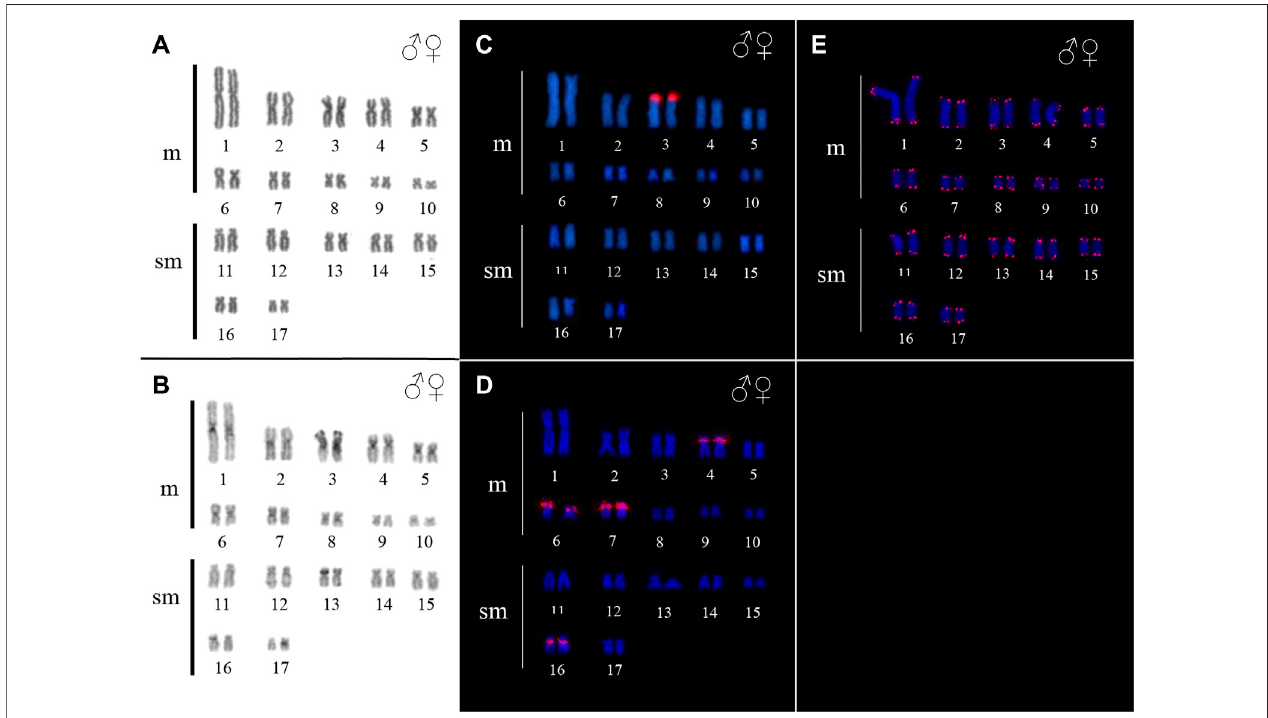
FIGURE 3 | Karyotype of Ancistrus sp. 2. In (A,B) karyotype stained with Giemsa and C-banding, respectively; in (C – E) in situ location of 18S rDNA, 5S rDNA and telomeric sequences, respectively. The probes were labeled with Cy3 (red), the chromosomes were counterstained with DAPI (blue).